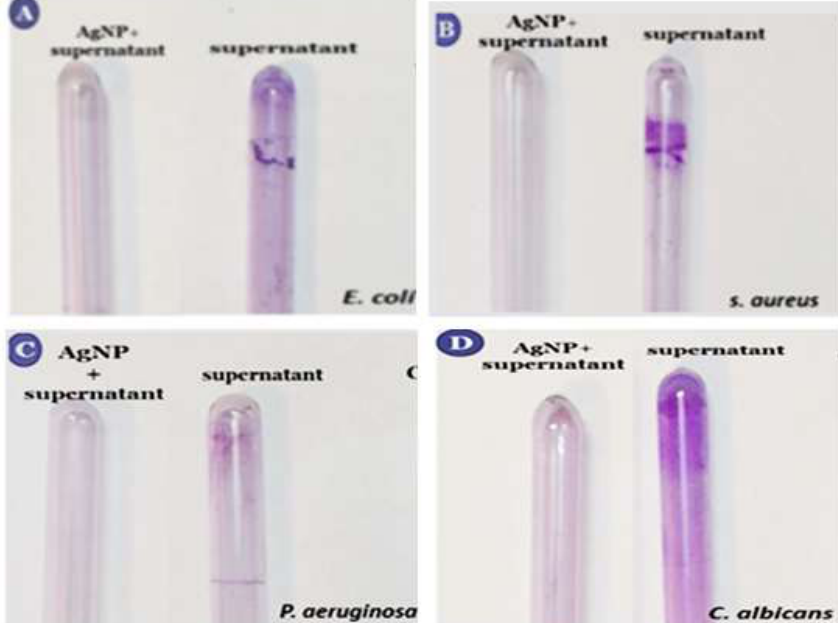
Figure 5. Qualitative detection of inhibition of the biofilm formation using tubes methods. (Supernatant) test tube refer to supernatant only without AgNPs (before treatment), (AgNPs + Supernatant) test tube refer to AgNPs synthesized by supernatant (after treatment).